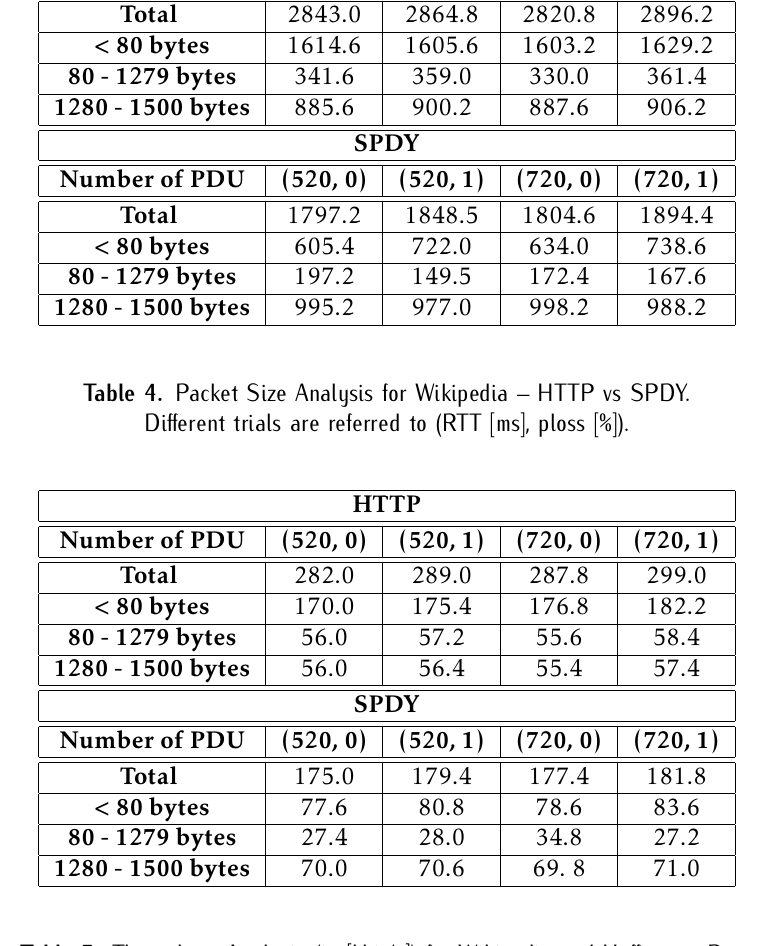
Table 5. Throughput Analysis (in [kbit/s]) for Wikipedia and Huffington Post. Different trials are referred to (RTT [ms], ploss